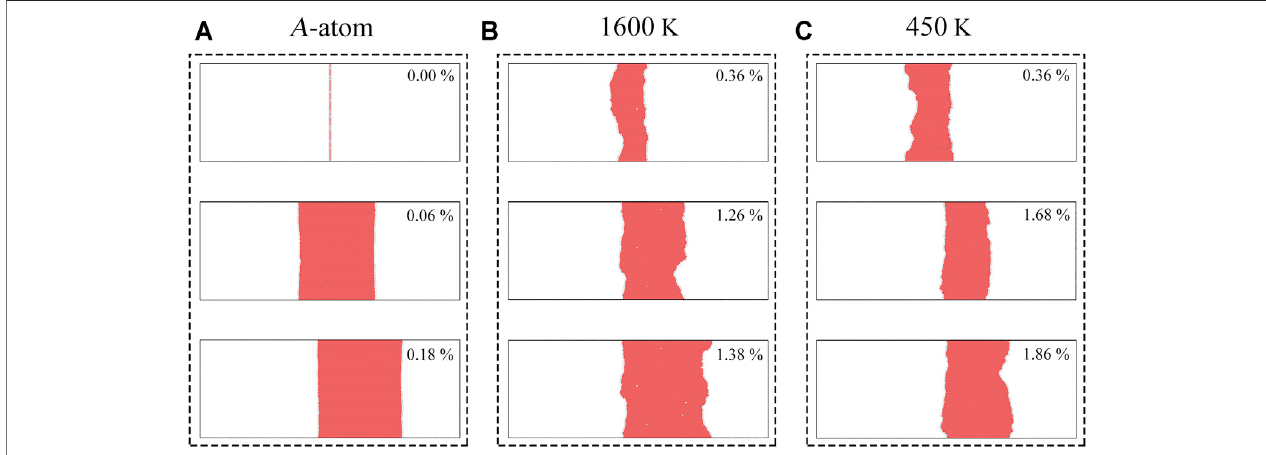
FIGURE 3 | Snapshots at various applied shear strains for the con fi guration and the movement of the edge dislocation in (A) the sample without nanoprecipitates simulated by the A-atom potential; (B) the sample without nanoprecipitates annealed at 1600 K; (C) the sample without nanoprecipitates annealed at 450 K.